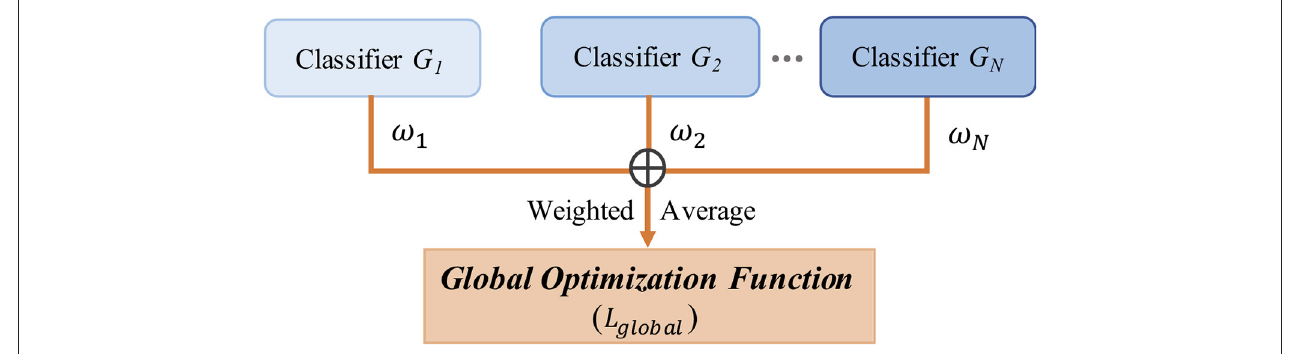
FIGURE 6 | The framework of global